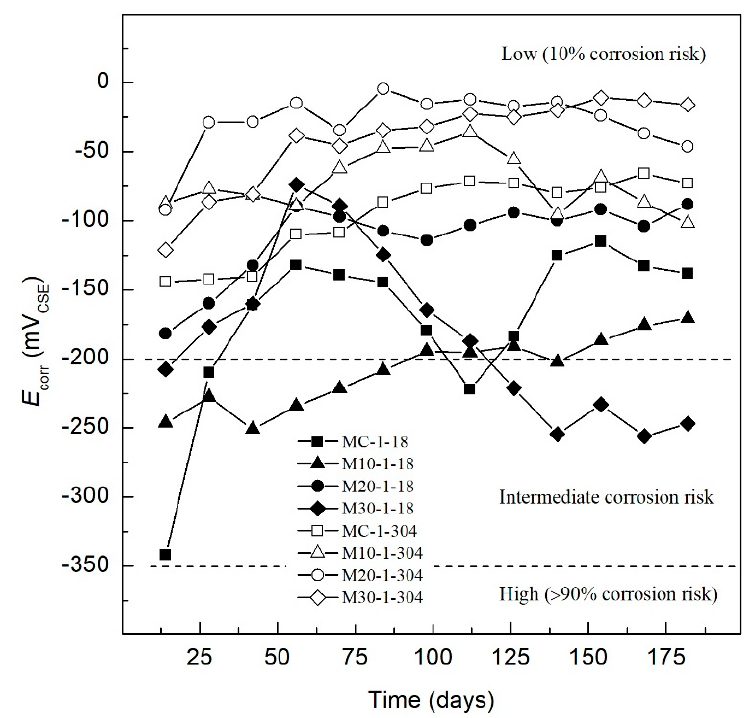
Figure 2. E corr of specimens exposed to control medium (DI-water).